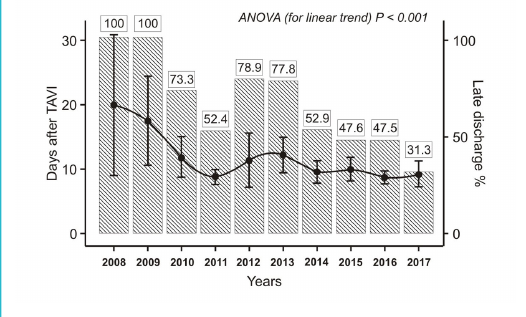
Figure 2: Year by year evolution of the length of hospital stay after TAVI presented in mean values and as percentage of patients dis- charged 1 week (or later) after the TAVI (late discharge, shaded columns).ANOVA = analysis of variance; TAVI = transcatheter